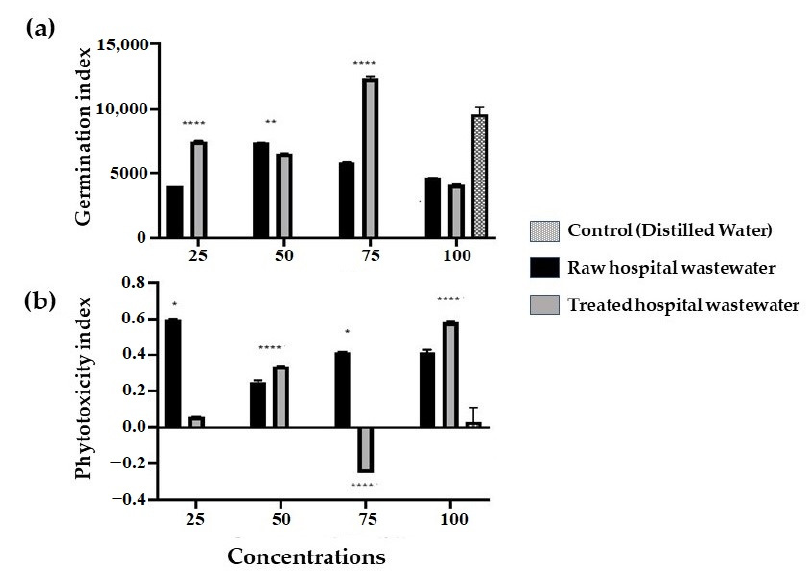
Figure 9. ( a ) Germination indices of Rice seeds grown in untreated and treated hospital wastewaters; ( b ) Phytotoxicity indices of Rice seeds grown in untreated and treated hospital wastewaters. Signif- icance (Welch’s test) between treated and untreated hospital wastewater is indicated by p < 0.05 *, p < 0.01 **, p < 0.0001 ****.